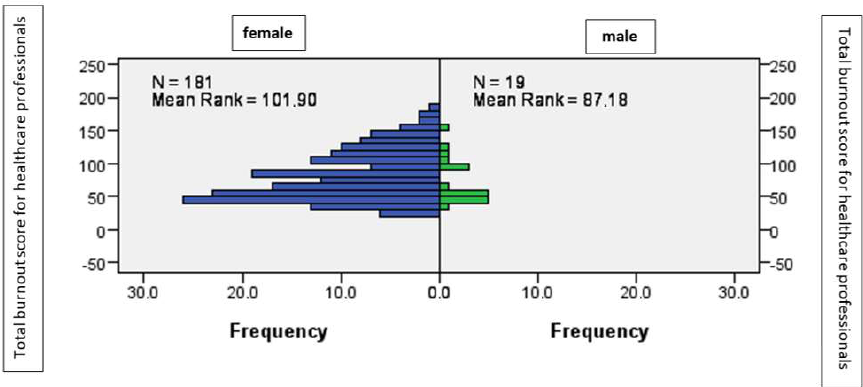
Figure 2. The average level of burnout according to gender.